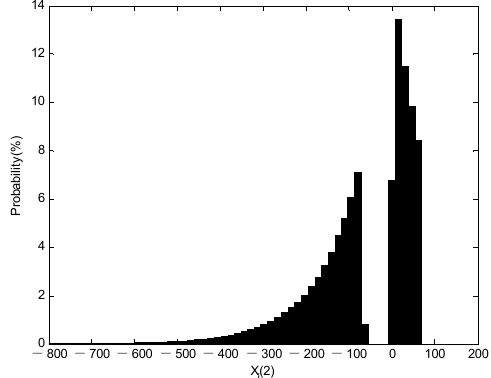
Figure 1. Frequency distribution histogram of X i (2).